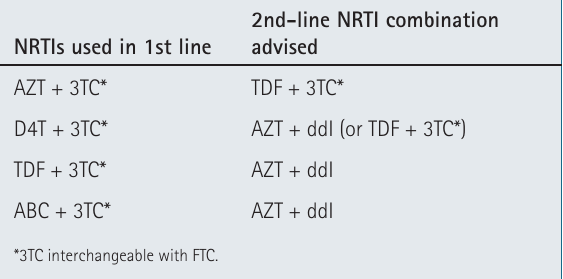
tAble V. choice of secoNd-liNe NRtis iN RelAtioN to fiRst-liNe NRtis